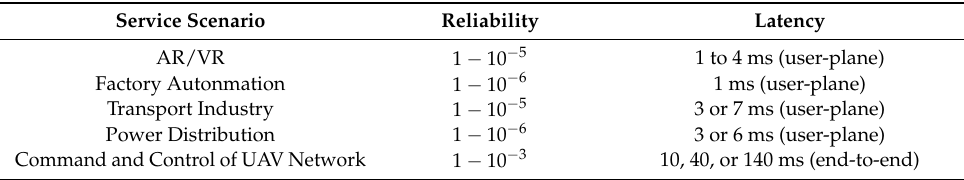
Table 1. Use Cases and Their Performance Requirements for